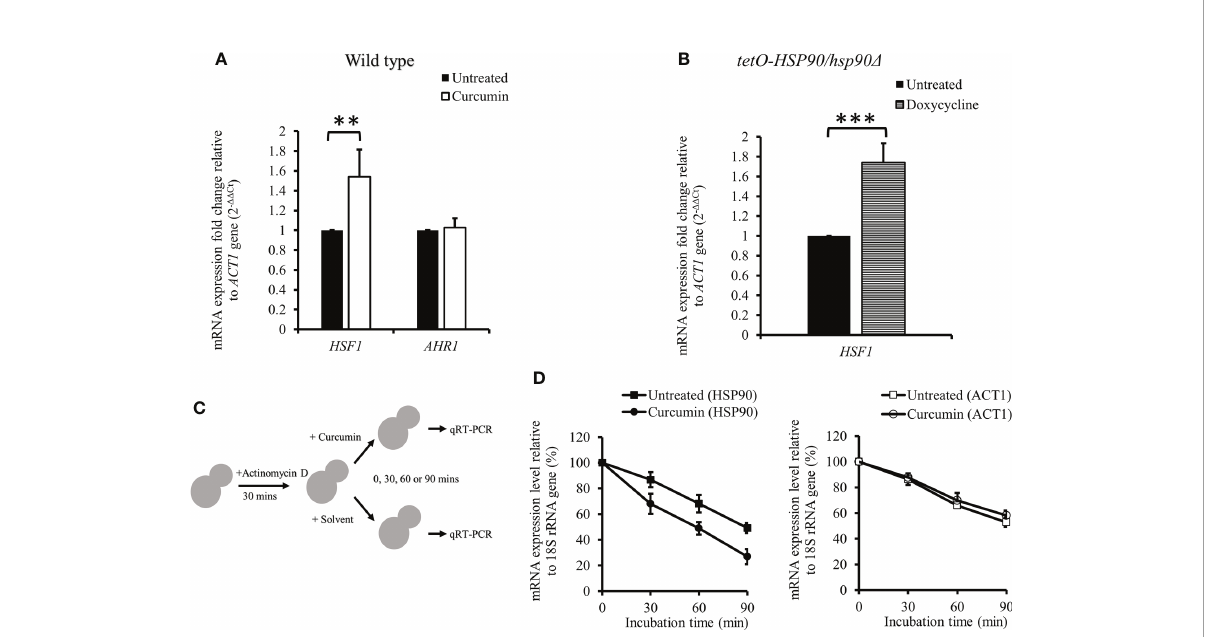
FIGURE 5 Effect ofcurcumin onthe gene expression of HSF1 and AHR1 and the post-transcriptional level of HSP90 . (A, B) Effectof curcumin on HSF1 and AHR1 gene expression in the wildtype and tetO-HSP90/hsp90 D strains aftertreatment with curcumin. Error barsrepresent standard deviationfromthe mean of duplicate measurements. **and *** indicate a statistically signi fi cant difference(p<0.01 and p<0.001) compared to the respective controlgroup. (C) Diagram showing the post-transcriptional regulation test. Cells were pre-treated with 10 µg/mLof actinomycin D for 30 min, then incubated with curcumin at sub-MIC 80 for 0, 30,60, or 90 min. (D) Effectof curcumin on HSP90 and ACT1 gene expression for the wildtype strainafter treatment with actinomycin D and curcumin. Error barsrepresent standarddeviation fromthe mean oftriplicate